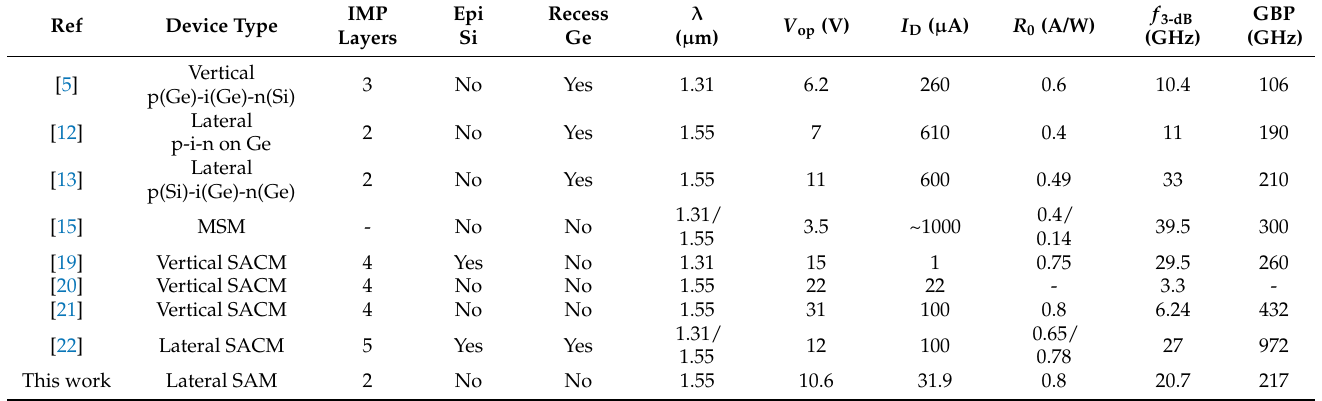
Table 1. Benchmarking table comparing the proposed waveguide-integrated lateral SAM Ge/Si APD with other state-of-the-art waveguide-integrated Ge/Si